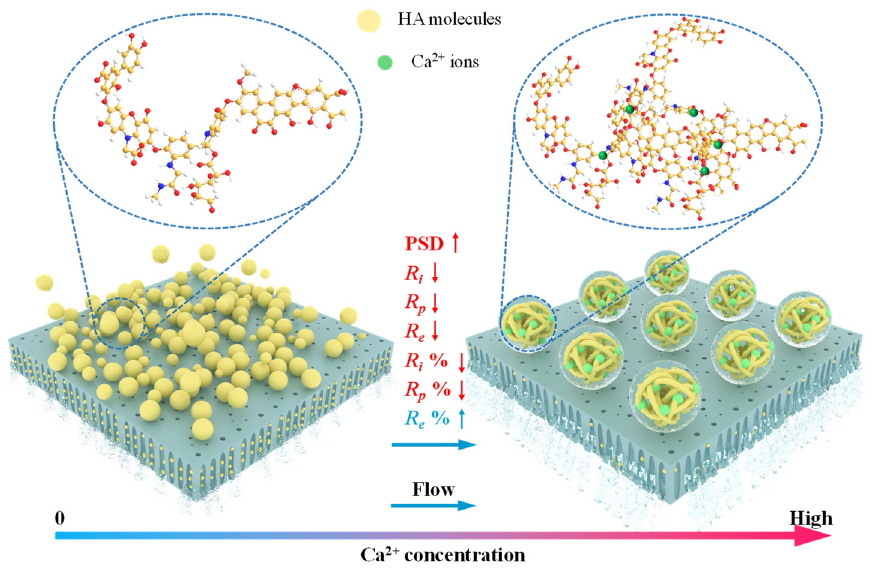
Figure 8. Schematic diagram of hydraulic resistance variation of HA with Ca 2+ addition in cross-flow filtration.